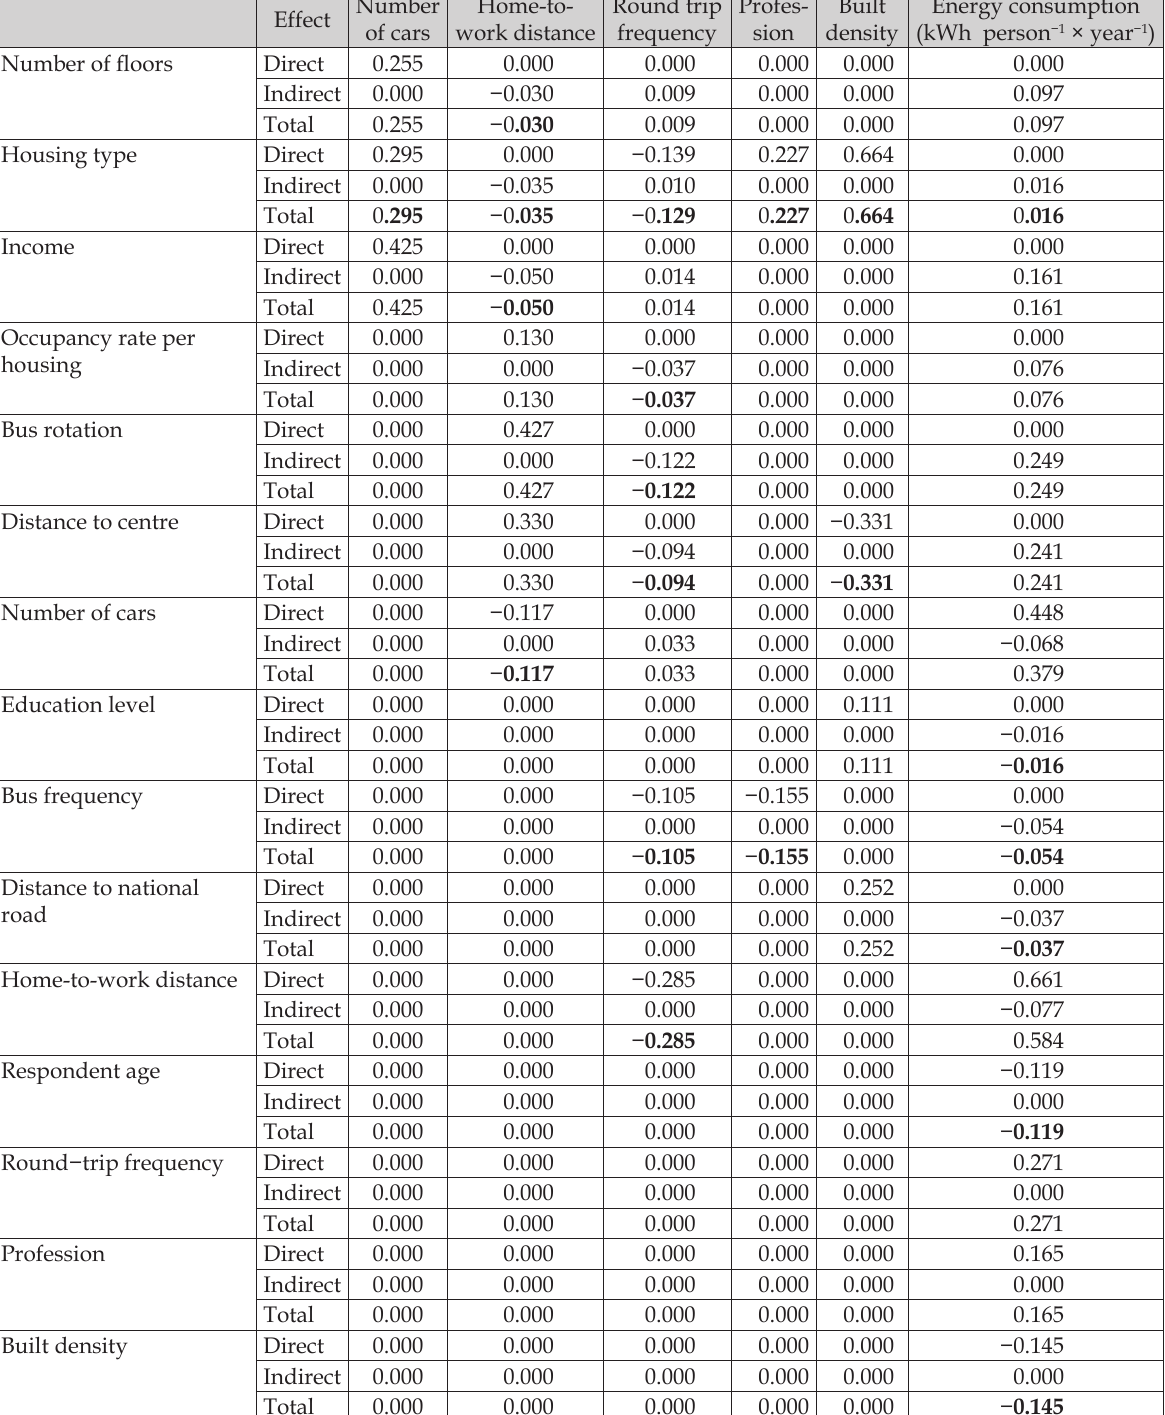
Table 7. Direct and indirect effects of the driving factors of energy consumption generated by